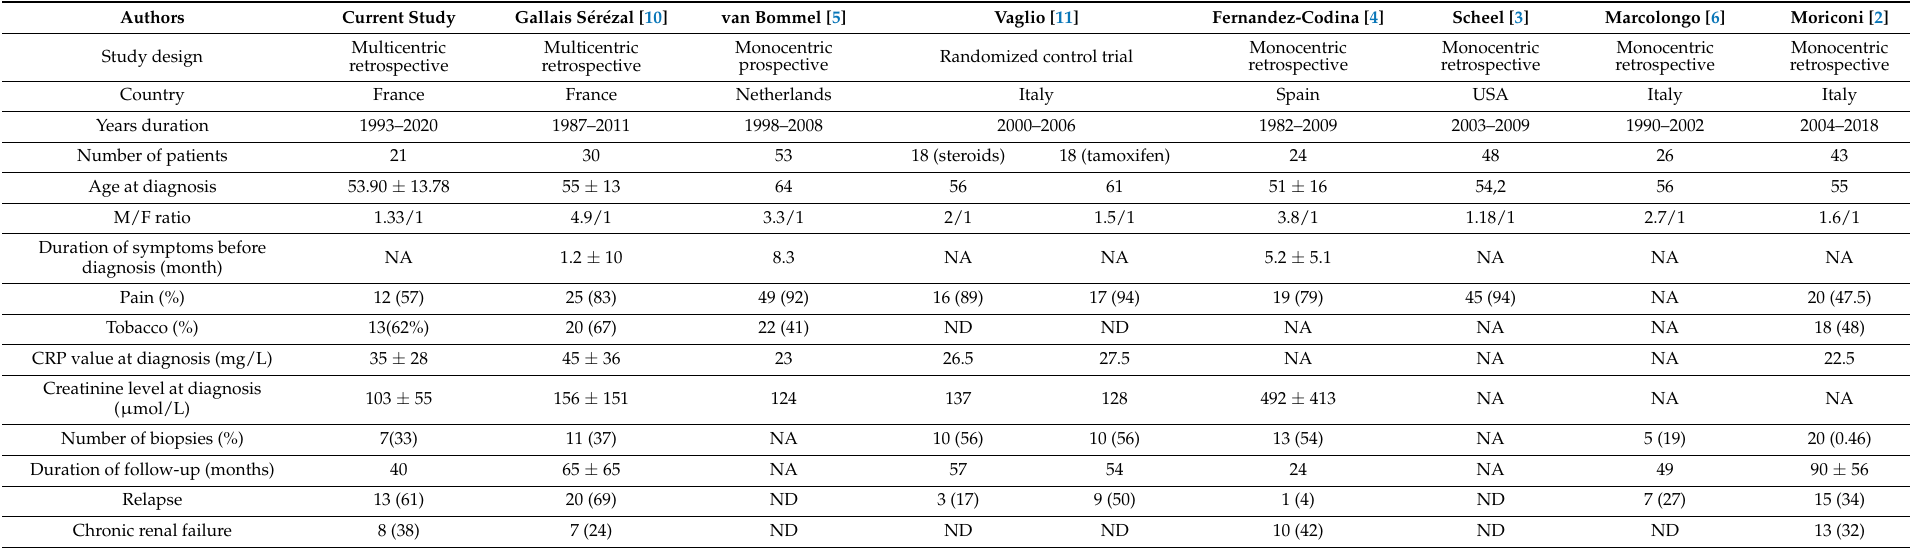
Table 3. Description of retroperitoneal fibrosis reported in